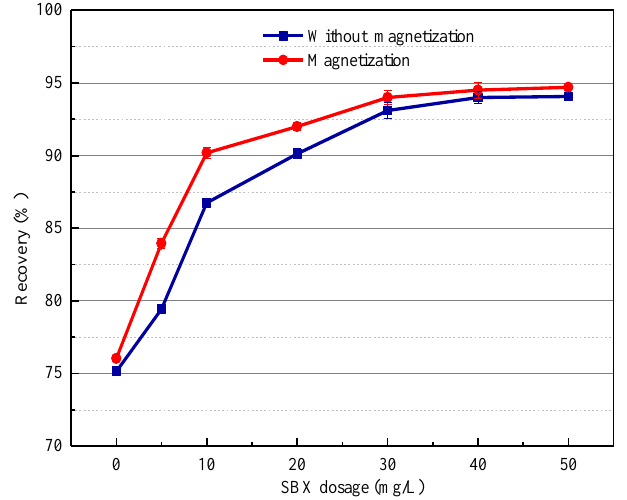
Figure 6. The relationship between butyl xanthate dosage and the recovery of chalcopyrite.